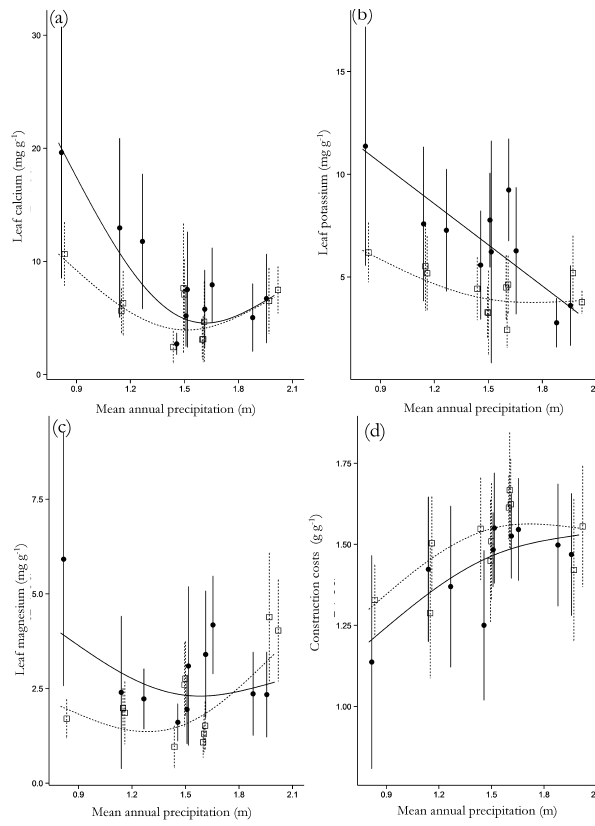
Figure 7. Variations in community-abundance-weighted mean fo- liar properties in relation to precipitation and vegetation formation type (a) leaf calcium (dry-mass basis), (b) leaf potassium (dry- mass basis), (c) leaf magnesium (dry-mass basis) and (d) leaf con- struction costs. ( • ) Forest plots; ( (cid:3) ) savanna plots. Fitted curves (solid for forest plots, dashed for savanna) represent generalised ad- ditive model fits. Error bars represent the community-abundance- weighted